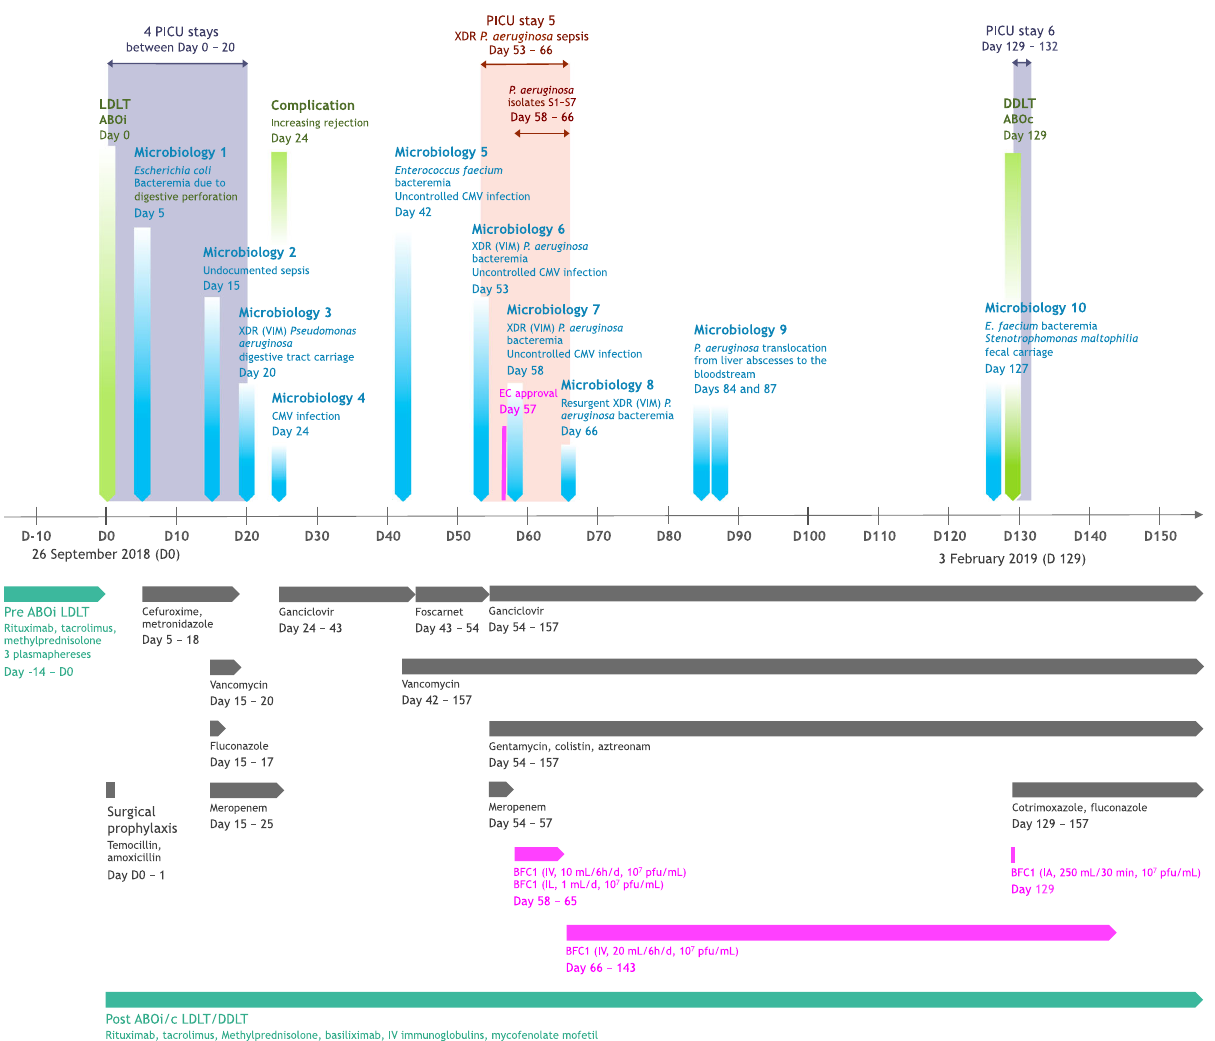
Fig. 1 | Clinical timeline. Timeline of the most relevant surgical procedures (light green), microbiological results (light blue), antibiotic therapies (dark gray), pre- and post-liver transplantation protocols (blue-green), and phage therapy (magenta). The child developed several early-onset post-operative complications, including liver rejection, anaphylactic shock on rituximab, biliary digestive anastomosis perforation followed by an Escherichia coli and Enterococcus faecium sepsis, and cytomegalovirus (CMV) infection. At day